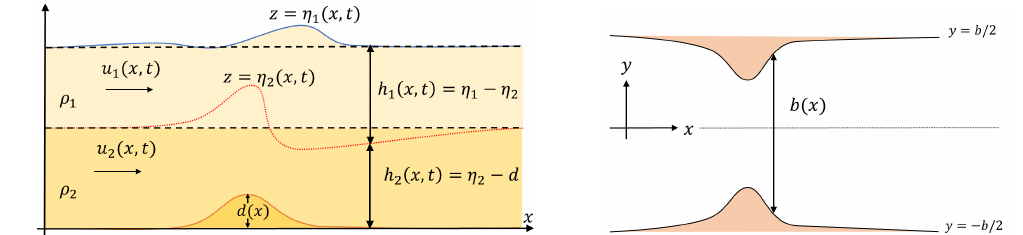
Figure 1. Sketch of the problem and notations. ( Left ) side view; ( right ) top